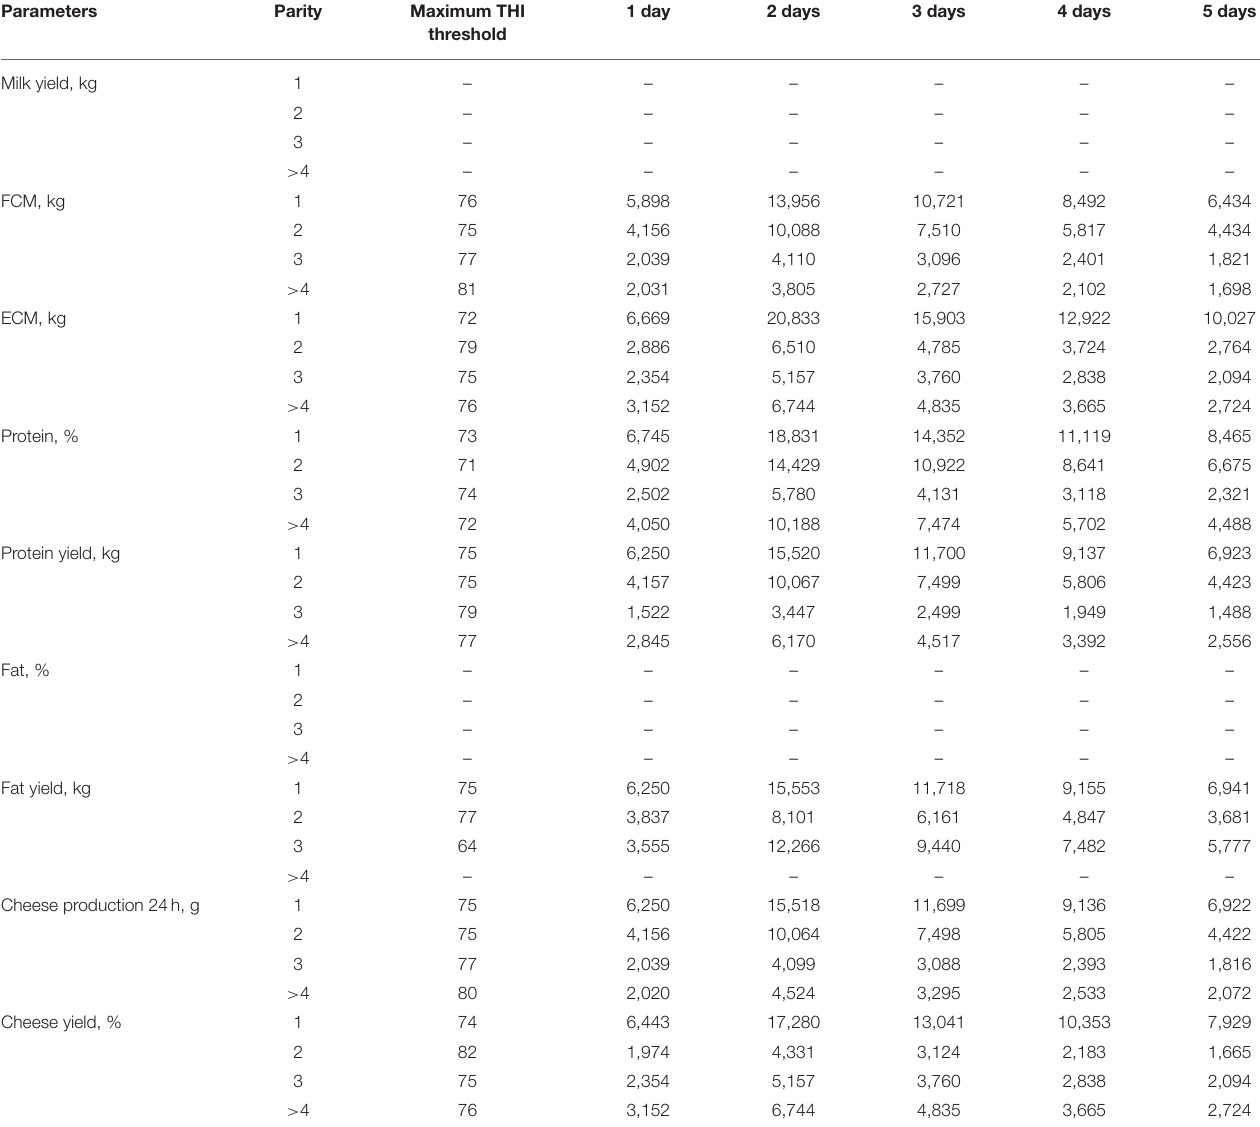
TABLE 1 | Maximum daily THI threshold values and number of records for each production trait and according to parity class.